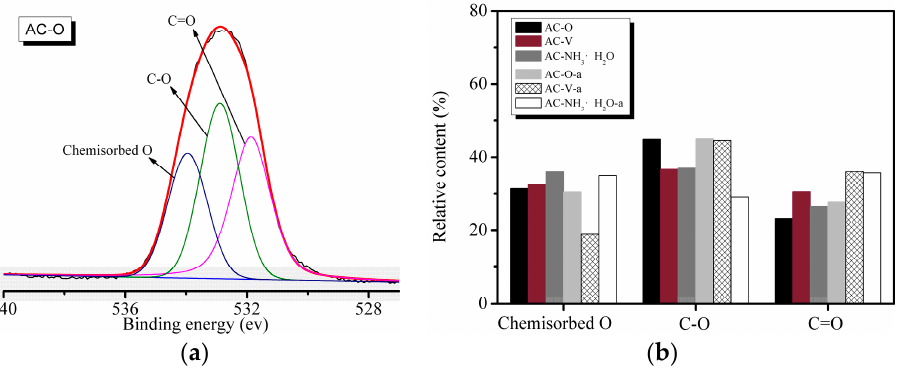
Figure 6. XPS results of the samples. ( a ) O 1s spectrum of AC–O. ( b ) Area percentages of the functional groups on the basis of the O 1s spectra.